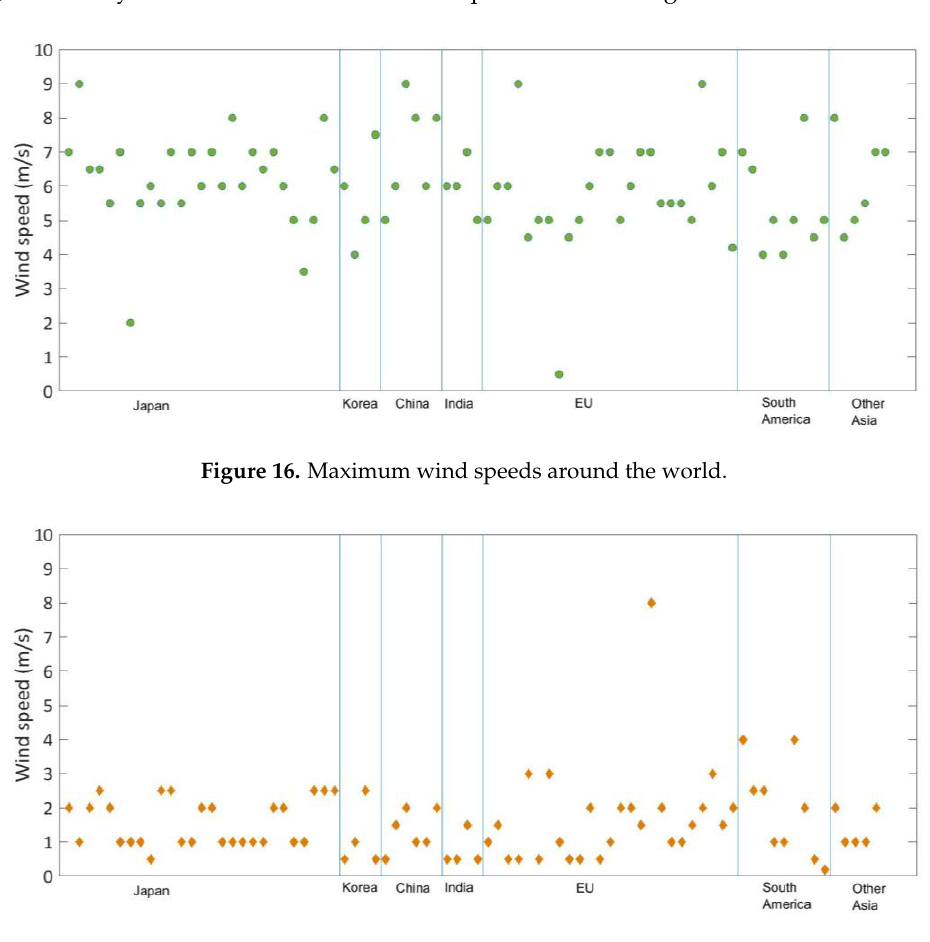
Figure 17. Minimum wind speeds around the world.